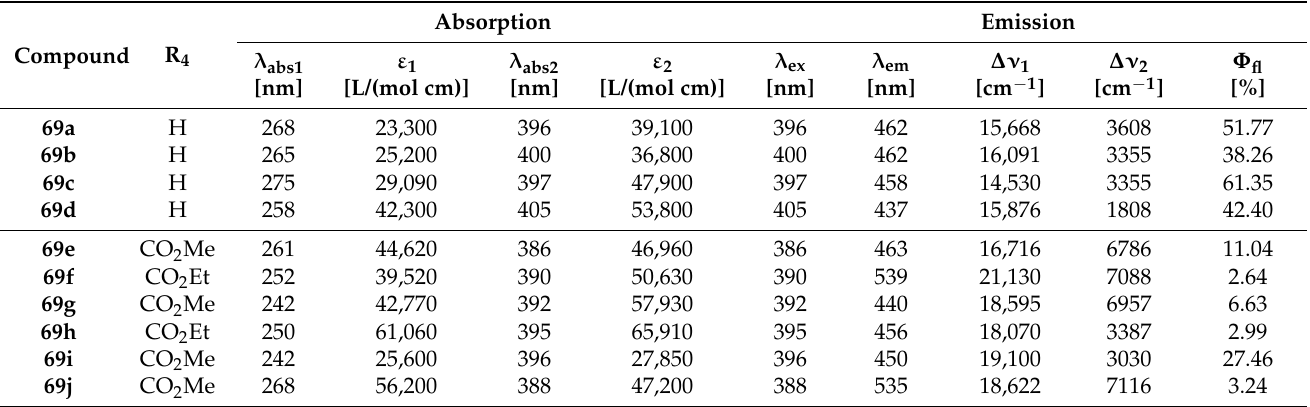
Table 12. The spectroscopic features for absorption and fluorescence of 69a – j in chloroform solution (10 − 6 M).